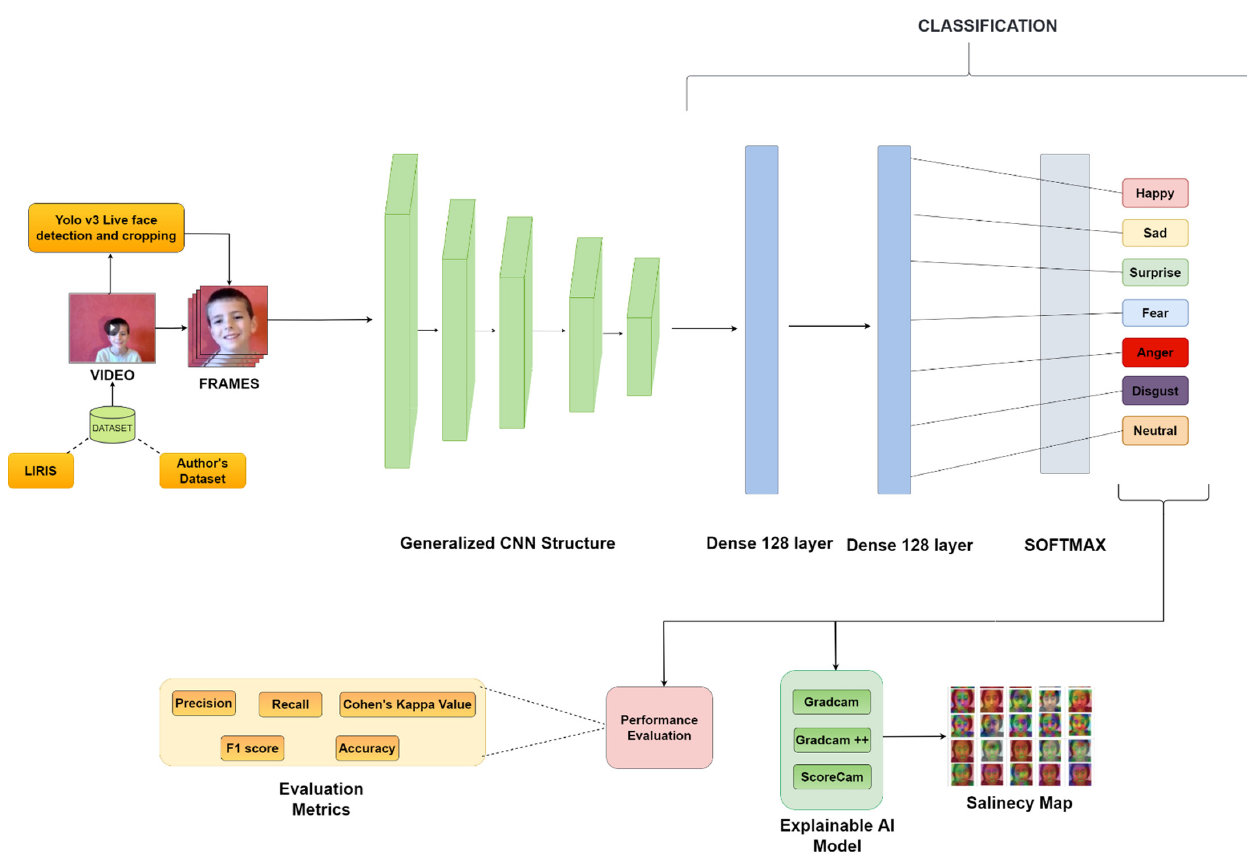
Figure 2. Architecture diagram of proposed emotion recognition.